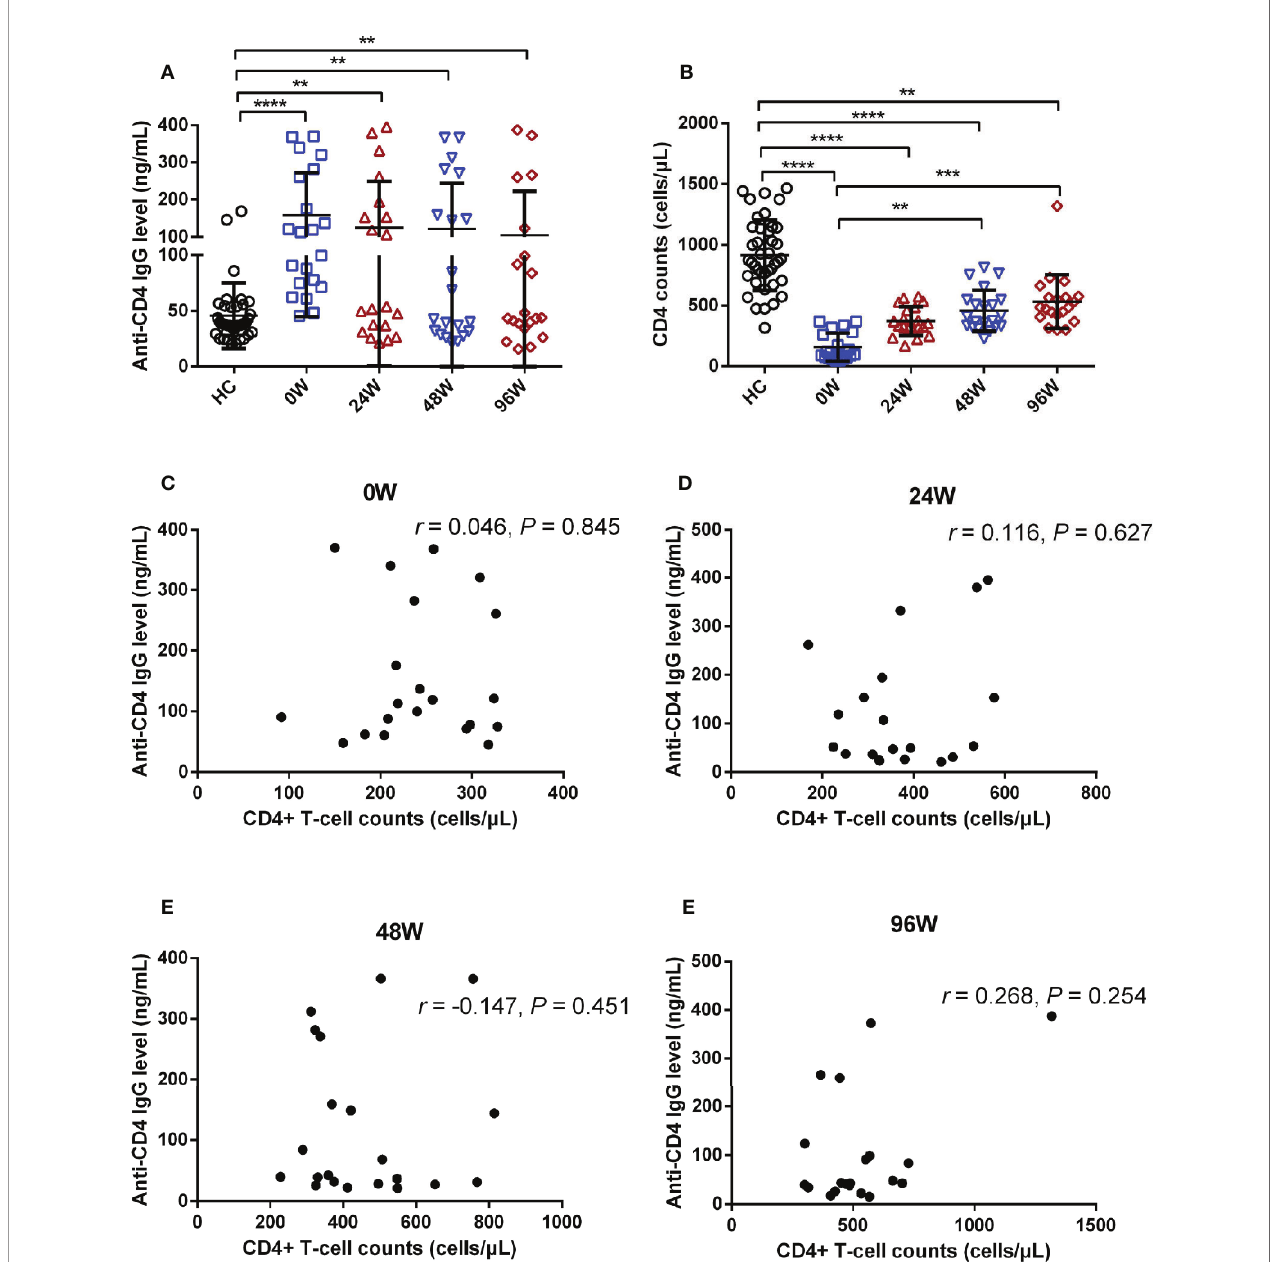
FIGURE 3 | Effect of Delayed Initiation of ART on Plasma Levels of Anti-CD4 IgG in AHI Individuals. Plasma anti-CD4 IgG levels (A) and CD4 + T-cell counts (B) in healthy controls (n = 40) and AHI (n = 21) individuals at 0 ( □ ), 24 ( △ ), 48 ( ▽ ), and 96 W ( ◇ ) after delayed initiation of ART. Correlations between plasma levels of anti-CD4 IgG and peripheral CD4 + T-cell counts in AHI individuals at 0 (C) , 24 (D) , 48 (E) , and 96 W (F) after delayed initiation of ART. One-way ANOVA tests and Spearman ’ s rank correlation tests, with P < 0.05 considered signi fi cant. ** P < 0.01, *** P < 0.001, **** P <